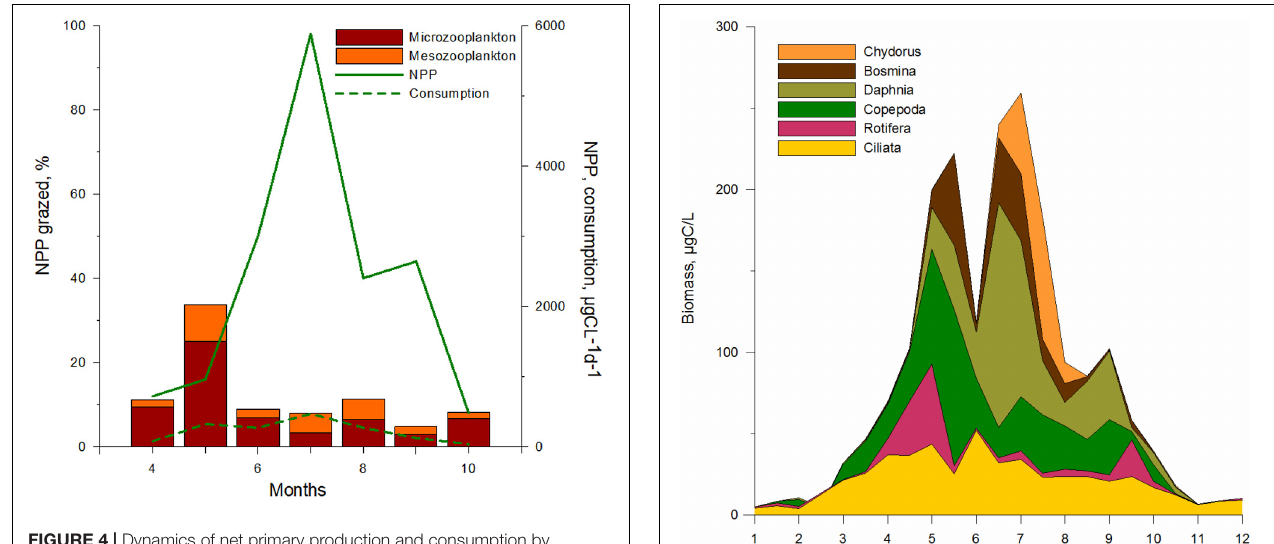
FIGURE 4 | Dynamics of net primary production and consumption by zooplankton (NPP, consumption, µ gCL − 1 d − 1 ), and estimated grazed NPP (%) by micro- and mesozooplankton during vegetative season in the Curonian Lagoon. diversity of ciliates indicating exploitation of a wide size